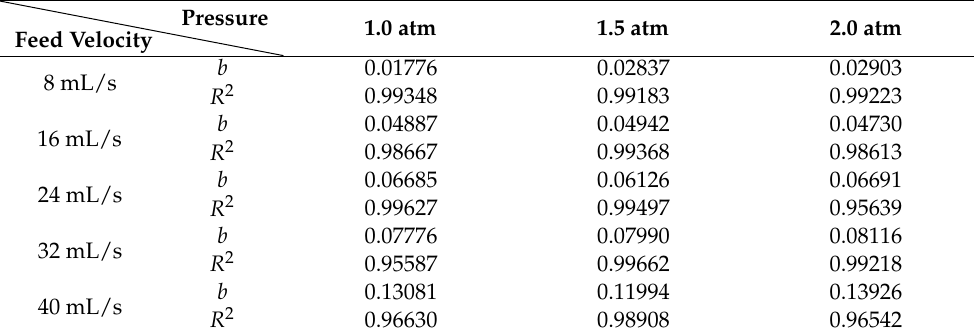
Table 2. Fitting parameters of each curve.